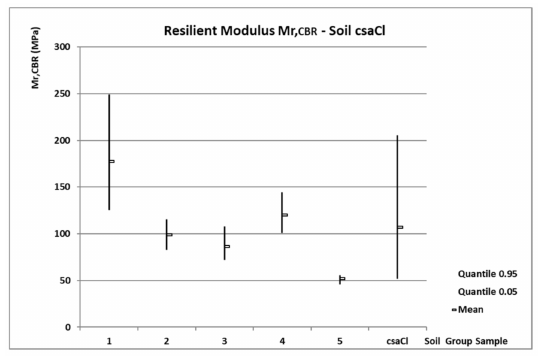
Figure 4. Statistical quantities—mean, 0.05 quantile, 0.95 quantile of M r,CBR for csaCl soil.